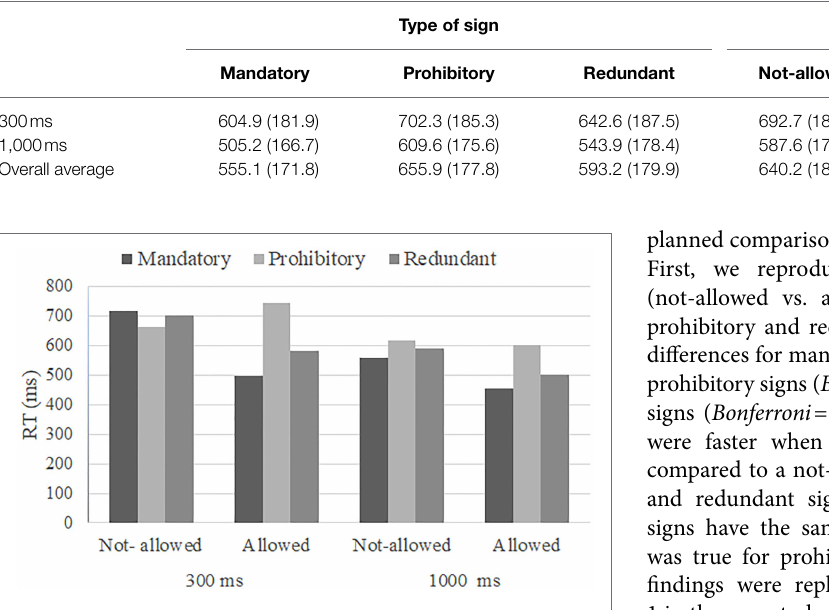
FIGURE 3 | Mean reaction time for the conditions manipulated in Study 1: time of exposure to traffic signs (300 vs. 1,000 ms), type of sign (mandatory vs. prohibitory vs. redundant) and manoeuvres (not-allowed vs.